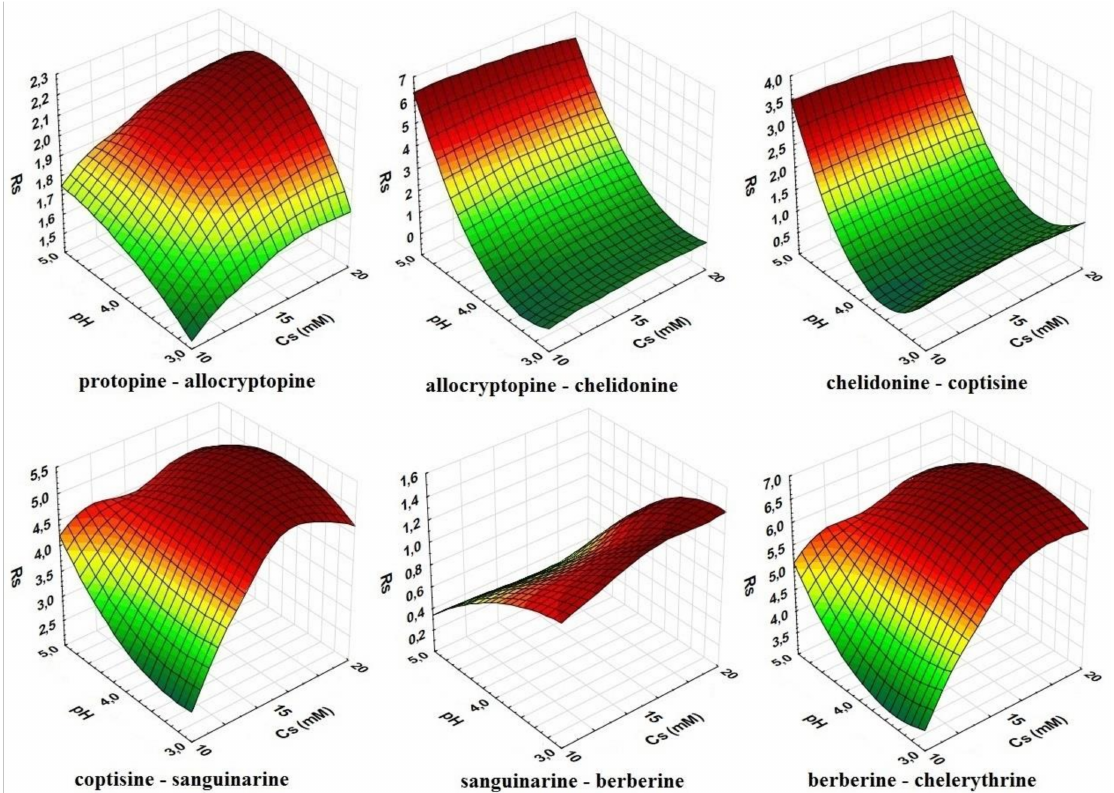
Figure 1. Relationship between the resolution (R s ) of neighboring peaks on the chromatogram and pH of the eluent and ammonium acetate concentrations in the mobile phase, which was composed of water and acetonitrile (8:2, v / v